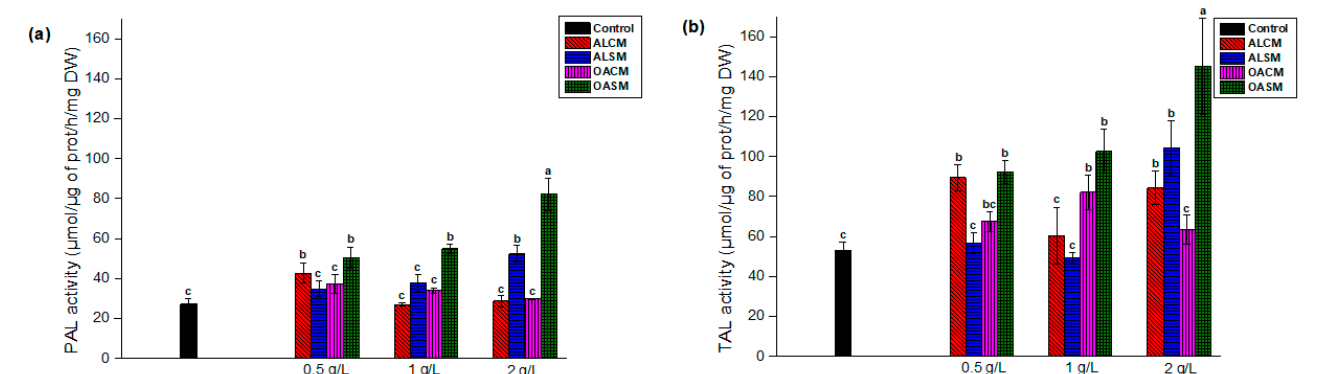
Figure 4. Effect of alginates extracted from CM (ALCM) and SM (ALSM) and their derivatives (OACM and OASM) on the induction of PAL ( a ) and TAL ( b ) activities in the leaves of olive tree after 24 h of treatment. The letters (a, b, c) indicate significant differences between treatments at each concentration using the Tukey-HSD test, at ( p < 0.05). Treatments presented with the same letter are not significantly different.